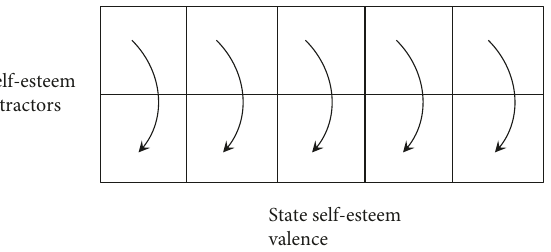
Figure 7: The intercell di ff erence between an individual ’ s two attractors was calculated for each level of state self-esteem. If the intercell di ff erence was high across all levels of state self-esteem, this indicated that each level of state self-esteem predominantly occurred while one (but not both) self-esteem attractors were expressed (i.e., high temporal correspondence). If the intercell di ff erence was low, it indicated that this speci fi c range of state self- esteem levels was experienced irrespective of the self-esteem attractor that is expressed (i.e., low temporal